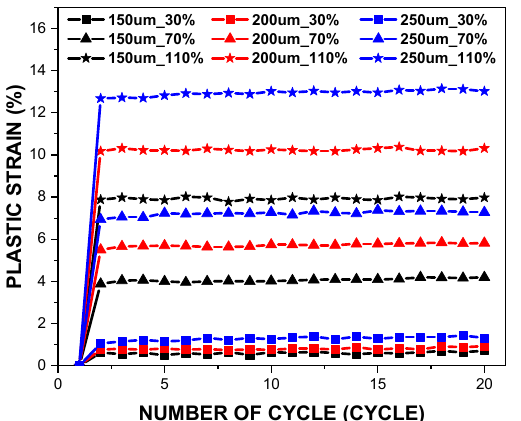
Figure 5. Deviations in the peak stress of the PDMS film with a thickness of 150 μ m over the cyclic tensile loading cycles.